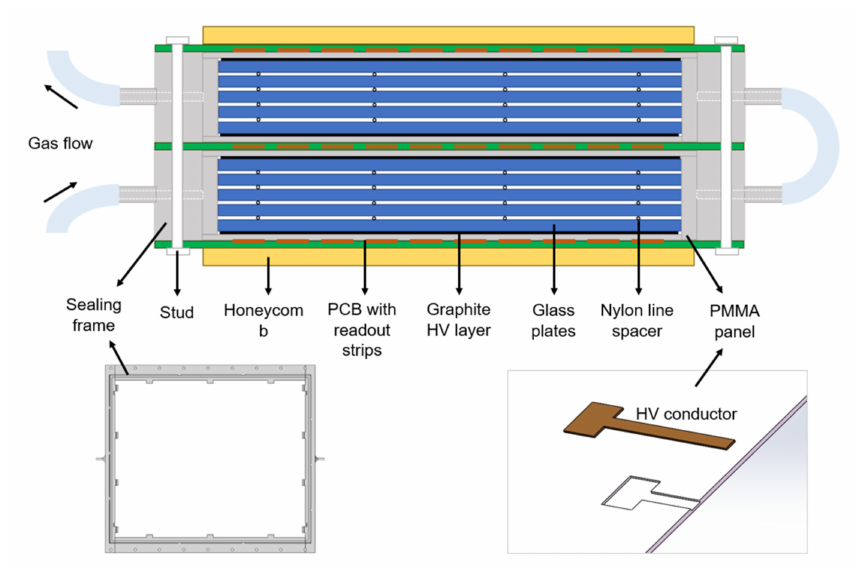
Figure 4. The schematic view of the high-rate sealed MRPC prototype, which has minute change from [12]. The PMMA plates are 1 mm in thickness. The copper HV conductor is pasted on the graphite